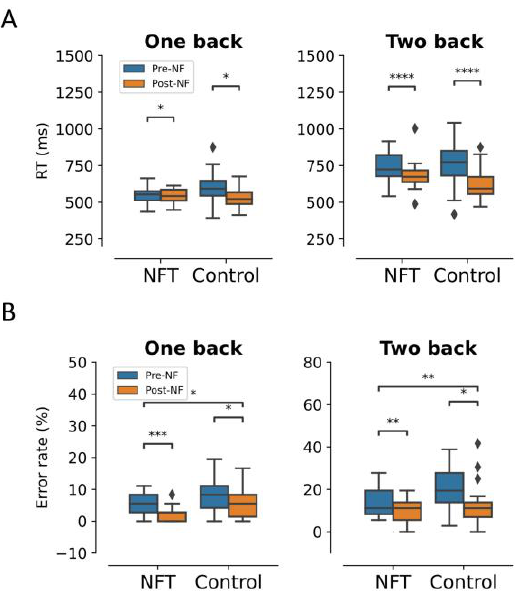
Figure 3. Behavioural results: ( A ) response time and ( B ) error rates. (* p < 0.05, ** p < 0.005, *** p < 0.0005, **** p < 0.00005). The diamond shape in the box plots represents the outliers in the data.